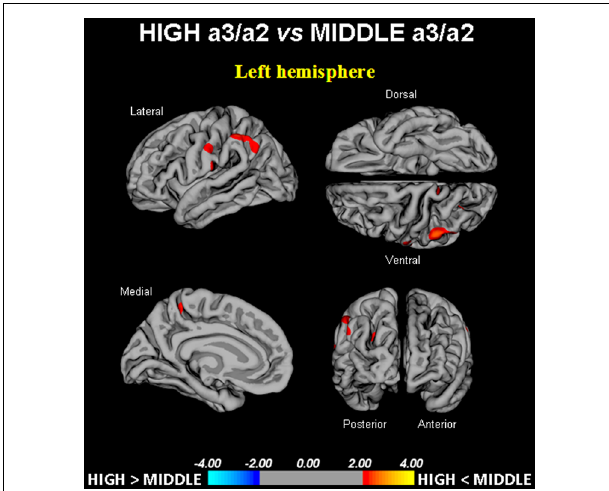
FIGURE 2 | In red are represented the brain regions with higher regional cortical thickness in MCI with high a3/a2 ratio as compared to MCI with middle a3/a2 ratio ( p < 0.01 uncorrected). The color-coding for p values is on a logarithmic scale. Results are presented on the pial cortical surface of brain: dark gray regions represent sulci and light gray regions represent gyri.